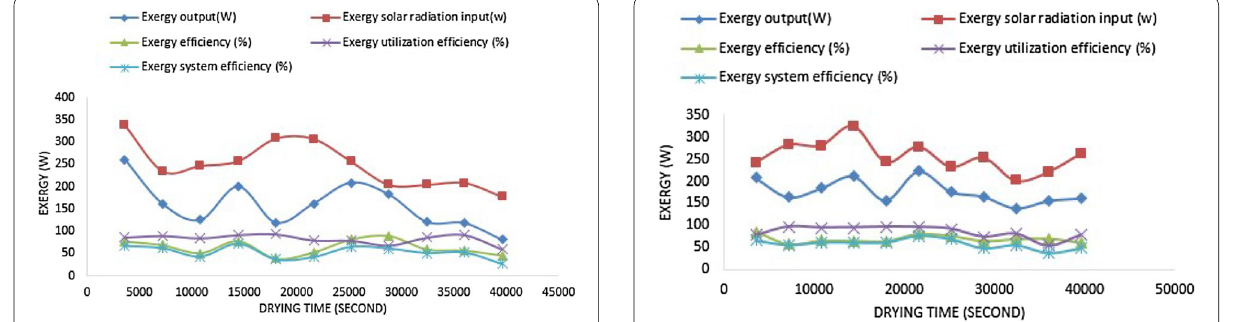
Fig. 15 Variation of efficiency as a function of drying time and exergy in the drying chamber (2nd day) tomato